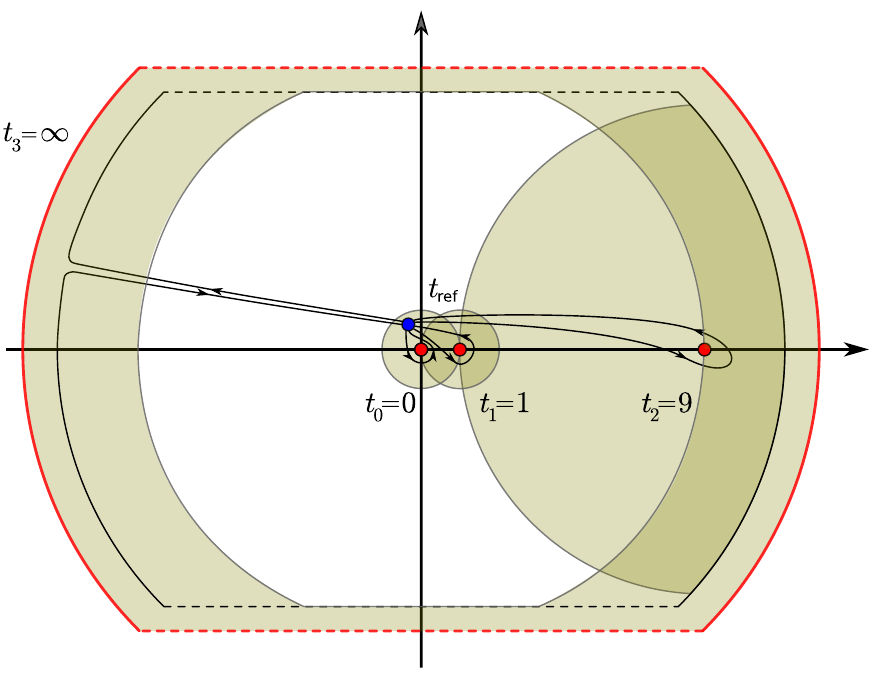
in eq. (5.4). The coefficient t